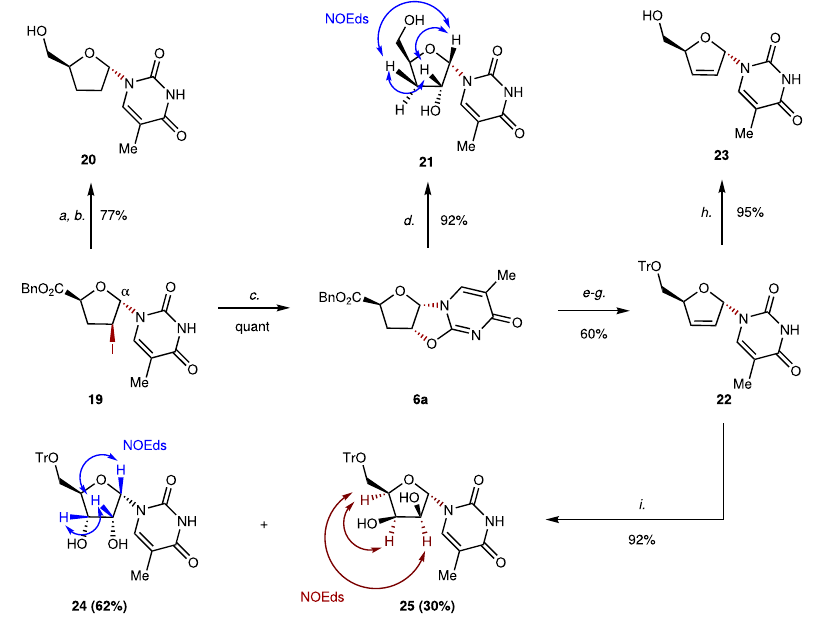
Fig. 6 | Derivatizations of α -nucleoside 19 . Conditions: a. a . Bu 3 SnH,AIBN, PhMe, re fl ux; b .NaBH 4 ,THF:H 2 O=3:1,0°Ctort.,77%overtwosteps; c .DBU,CH 2 Cl 2 ,0°C, quant; d . NaBH 4 , THF:H 2 O=3:1, rt., 92%; e . NaBH 4 , THF:H 2 O=3:1, 0°C; f . TrCl,